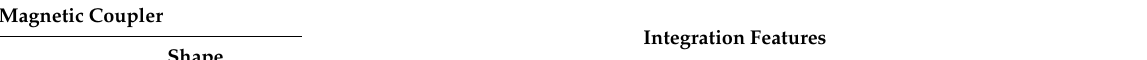
Table 4. Comparison of magnetic couplers used for compensation topology integration